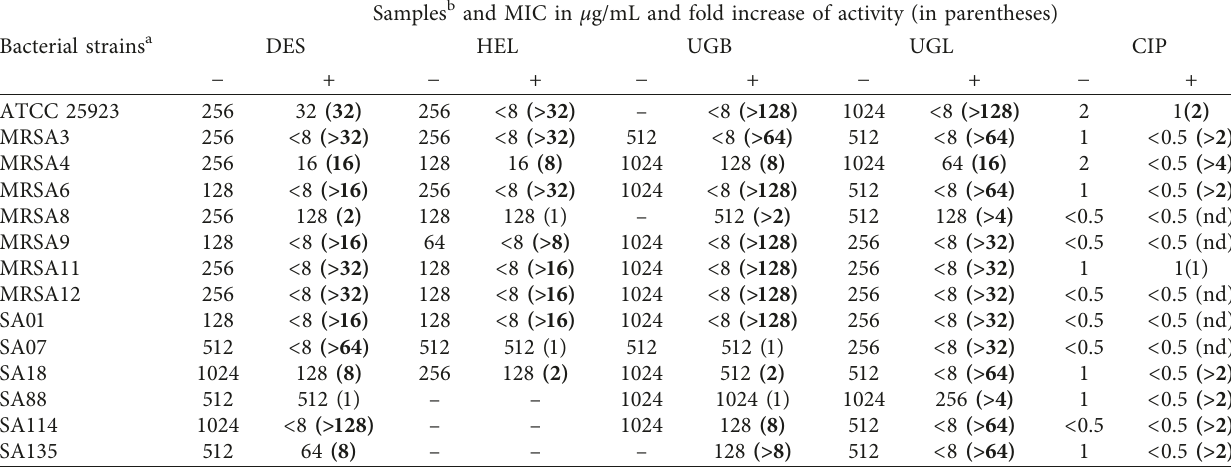
Table 5: MIC of extracts and ciprofloxacin in the absence ( − ) and presence (+) of carbonyl cyanide m -chlorophenyl hydrazone (CCCP) against selected strains of Staphylococcus aureus . Samples b and MIC in µ g/mL and fold increase of activity (in parentheses) Bacterial strains a DES HEL UGB